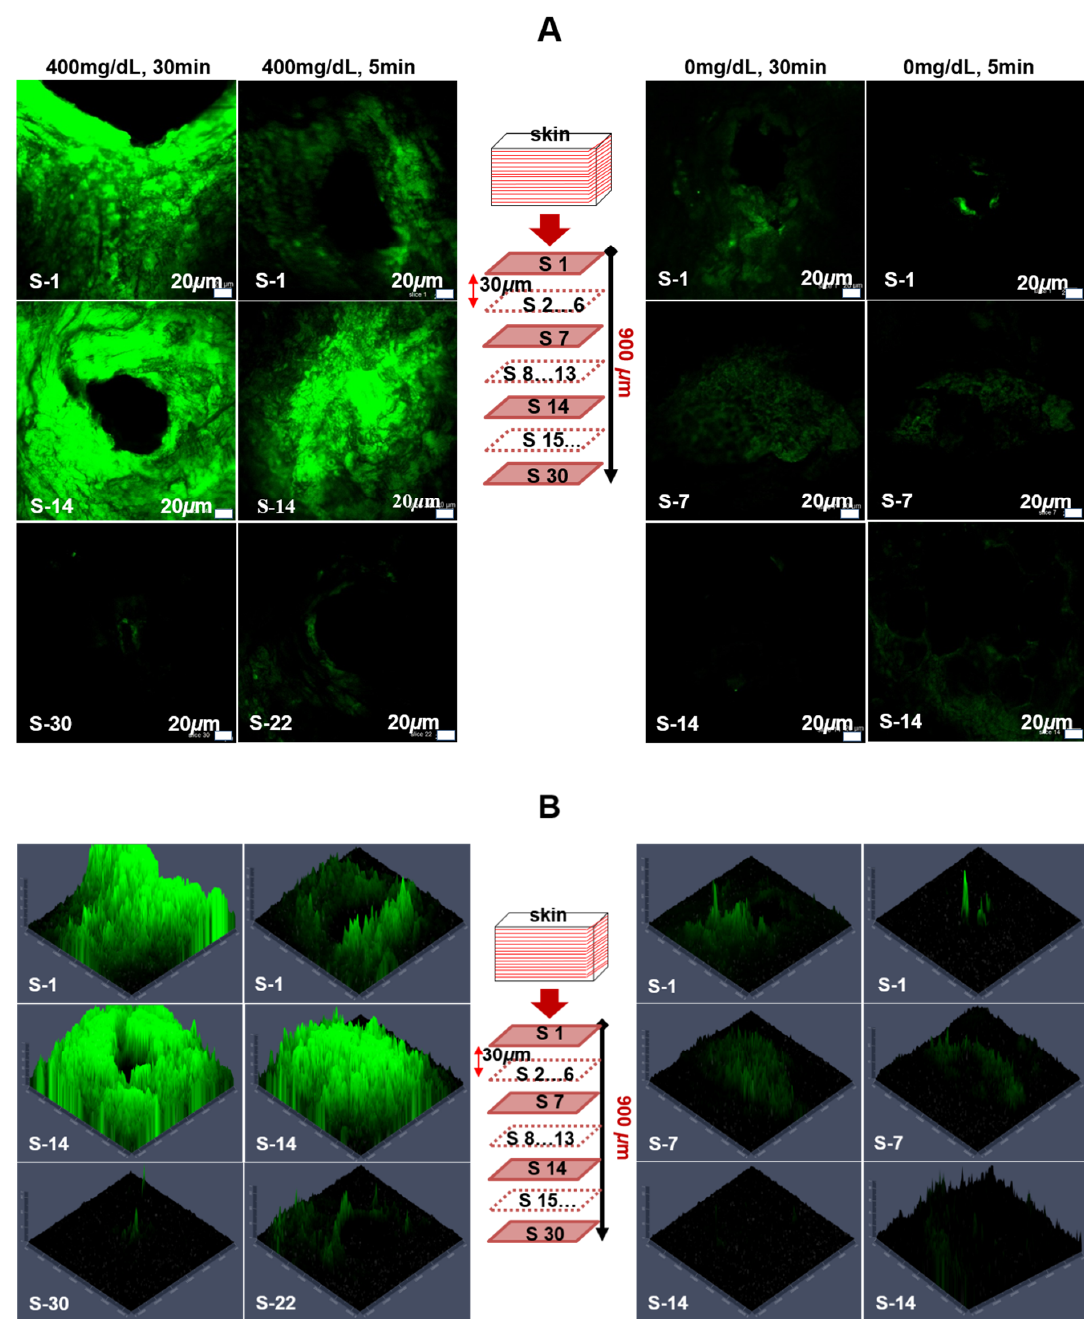
Figure 5. Confocal laser scanning micrographs of histological sections for fluorescein isothiocyanate ( FITC)-labeled insulin delivery in porcine skin at 37 °C. Histological sections were obtained by slicing the FITC-labeled insulin delivered skin tissues using a microtome. A: (left side); FITC-labeled insulin delivered to skin at 400 mg/dL for 5 and 30 min, S-1 represents the top skin section, whereas S-30 represents the deepest section for which FITC-labeled insulin was detected. The thickness of each section was 30 μm. ( A ) (right side); FITC-labeled insulin delivered to skin at 0 mg/dL for 5- and 30-min. S-1 represents the top skin section, whereas S-14 represents the deepest section for which FITC-labeled insulin was detected. ( B ) Corresponding fluorescence intensities of FITC-labeled insulin delivered to skin at 400 mg/dL for 5 and 30 min (left side) and 0 mg/dL for 5 and 30 min (right side).